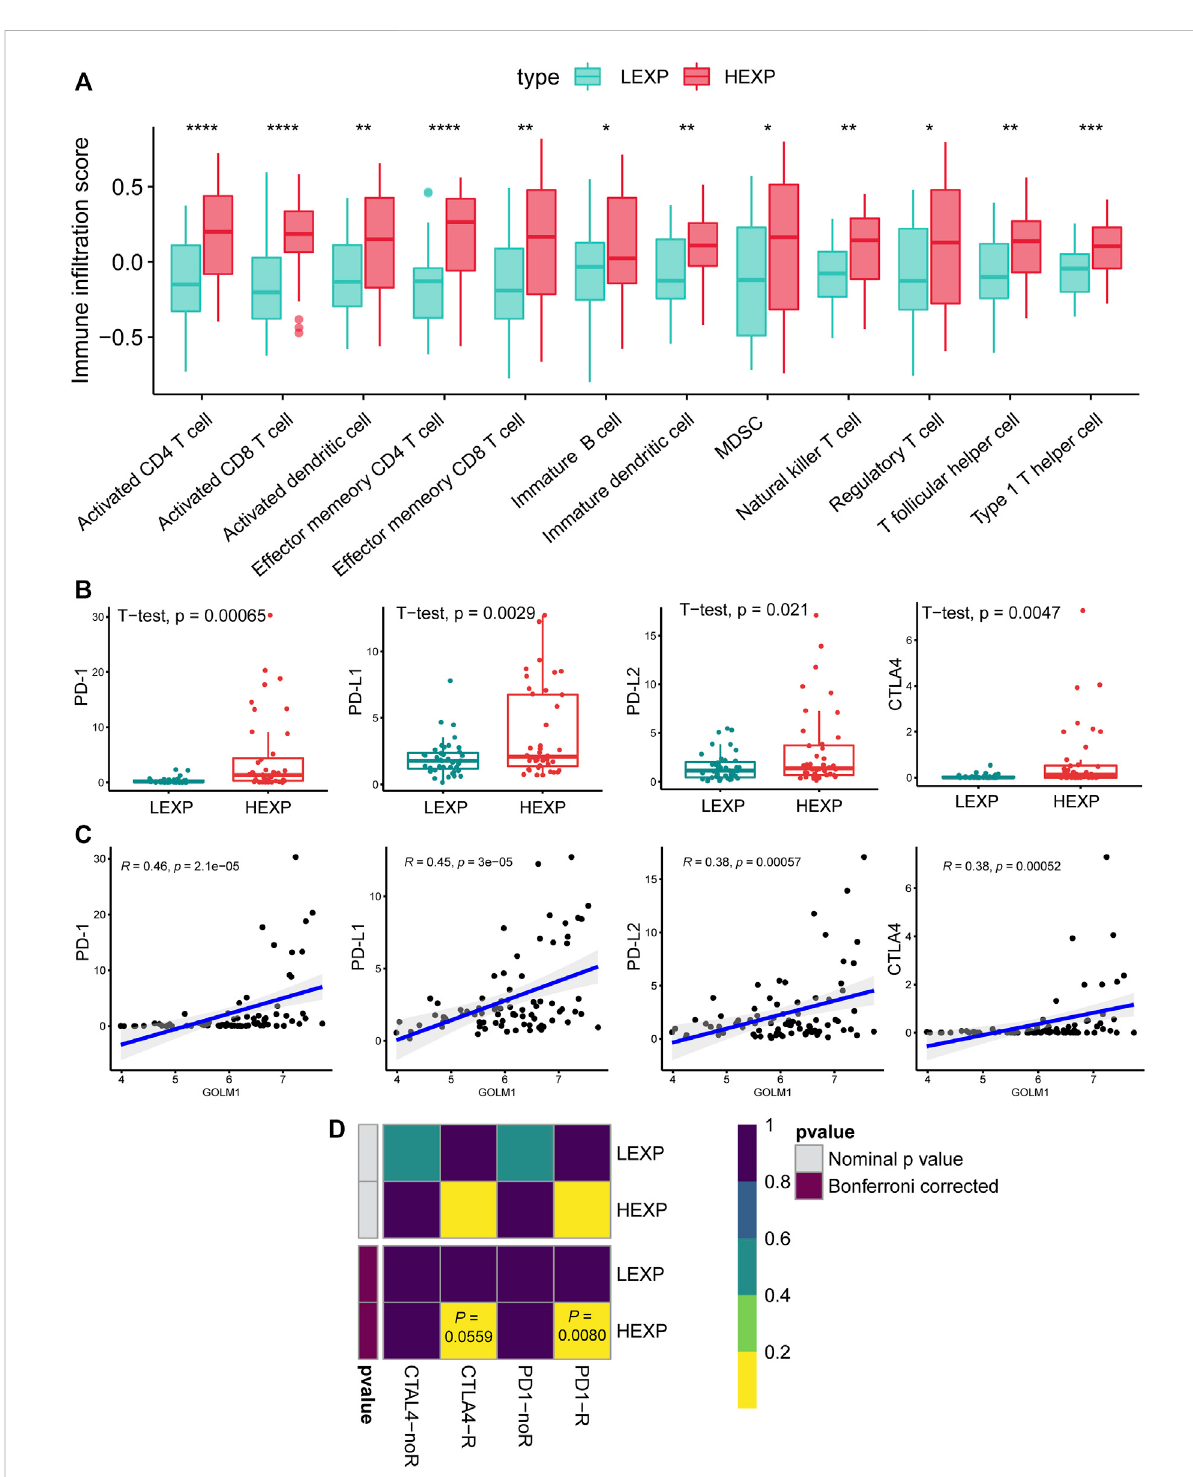
FIGURE 4 GOLM1islinkedwithtumor-in fi ltrated immunocytes andimmunotherapy. (A) Differentialin fi ltrationofimmunocytesintheGOLM1-low(LEXP) groupcomparedtotheGOLM1-high(HEXP)groupofTheCancerGenomeAtlas(TCGA)-uvealmelanomacohort; (B) DifferentialexpressionofPD-1, PD-L1,PD-L2,andCTLA4intheLEXPandHEXPsubgroupsoftheTCGA-uvealmelanomacohort; (C) CorrelationbetweenGOLM1andfourimmune checkpoints; (D) Prediction of the response to anti-CTLA4 and anti-PD-1/PD-L1